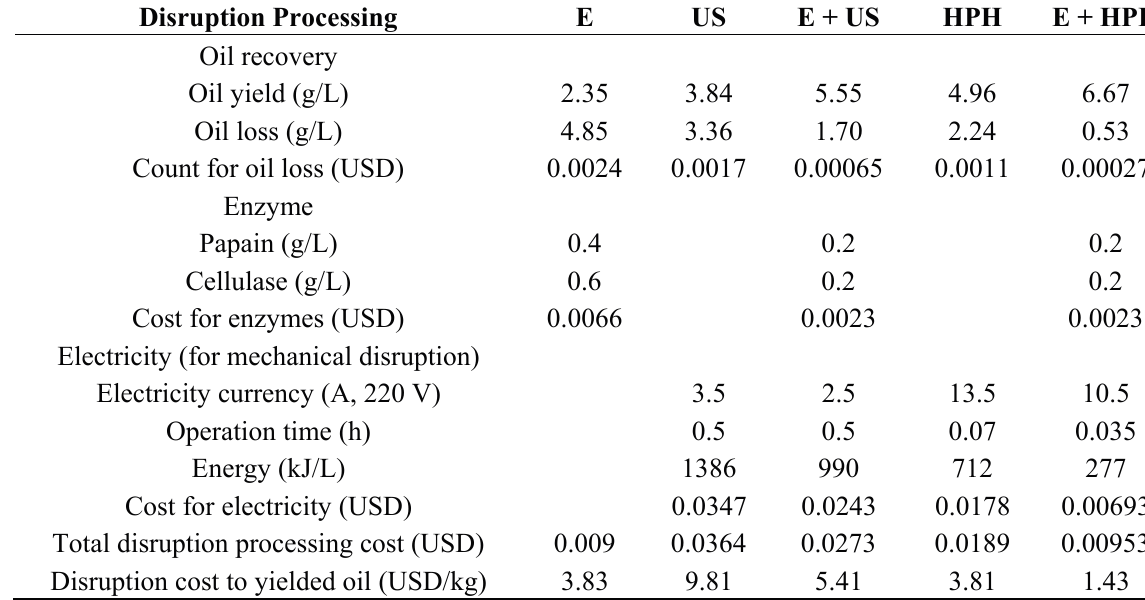
Table 1. Comparisons of costs and lipid yields in different disruption processes. 1. The value of un-extracted oil (lost in algal suspension) is calculated as 0.50 USD/kg, which is estimated according to the alga cultivation cost, and the oil loss is calculated by Soxhlet oil yield (7.2 g/L) minus the oil yield of selected process. 2. The prices of enzymes and electricity refer to the Chinese market. 3. The electricity cost in enzymatic process is